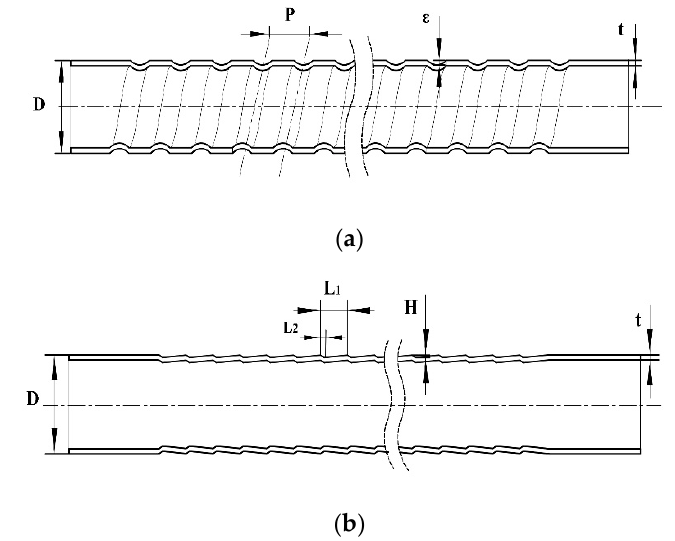
Figure 1. Schematic structures of two highly efficient heat exchange (HEHE) tubes: ( a ) Spirally grooved (SG) tube, ( b ) Converging–diverging (CD) tube.